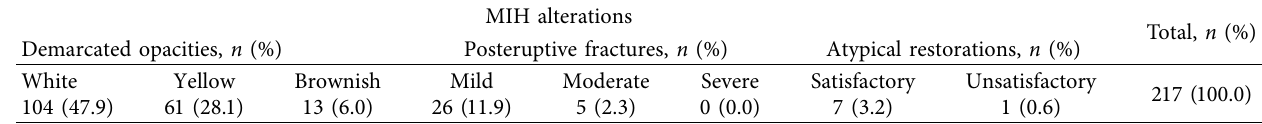
Table 3: Frequency of teeth afected by MIH, according to observed